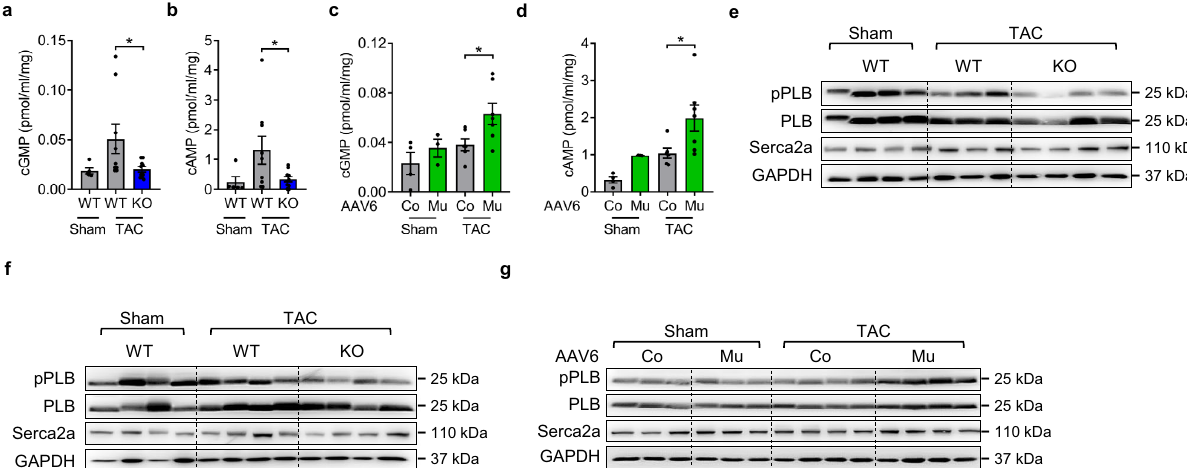
Fig. 7 Skeletal muscle Musclin regulates cardiac cGMP and cAMP levels and phospholamban phosphorylation at the PKA phosphorylation site (Serine 16). Cardiomyocyte cGMP ( a , * p = 0.0268), ( c , * p = 0.048) and cAMP ( b , * p = 0.029), ( d , * p = 0.025) levels (determined by ELISA) after sham and TAC surgery in control (WT) and Musclin knockout (KO) mice after TAC, as well as in Sham and TAC operated mice treated either with AAV6 Control (Co)